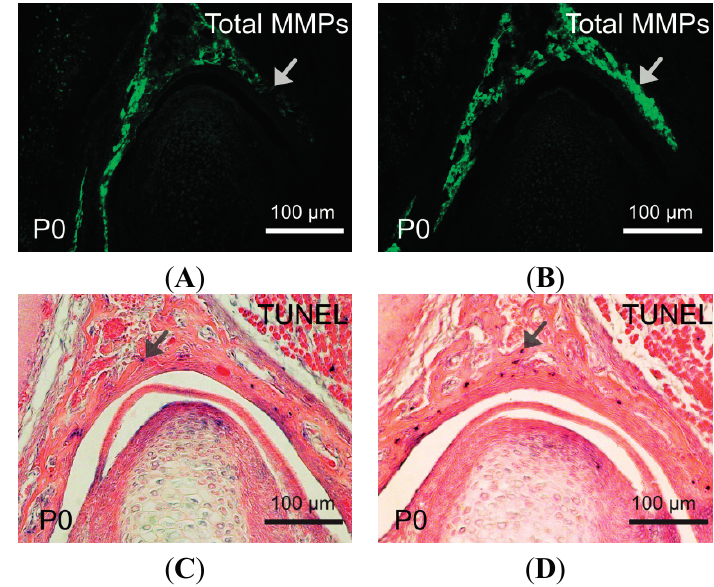
Figure 5. Altered expressions of MMPs and apoptosis in the postnatal TMJ of Wnt1-Cre ; pMes-stop Shox2 mice. ( A , B ) In situ zymography on coronal sections of wild type ( A ) and Wnt1-Cre ; pMes-stop Shox2 ( B ) TMJ shows MMPs activity. The ectopic MMPs activity in the glenoid fossa (arrow heads) of the Wnt1-Cre ; pMes-stop Shox2 TMJ; TUNEL assay on coronal sections of P0 wild type ( C ) and Wnt1-Cre ; pMes-stop Shox2 ( D ) TMJ shows an increase of apoptotic cells in the glenoid fossa of the Wnt1-Cre ; pMes-stop Shox2 TMJ. Arrow heads in ( C , D ) point to the apoptotic cells in the glenoid fossa; ( E – L ) Immunohistochemical staining on coronal sections of wild type ( E , G , I , K ) and Wnt1-Cre ; pMes-stop Shox2 ( F , H , J , L ) shows expressions of MMP9 ( E – H ) and MMP13 ( I – L ). Arrow heads in ( E – H , K , L ) point to the protein levels of MMP9 and MMP13 in the condyle and glenoid fossa where expression is altered; ( M ) Comparison of numbers of apoptotic cells in the glenoid fossa between wild type and Wnt1-Cre ; pMes-stop Shox2 mice. Standard deviation is shown as error bars. * p <